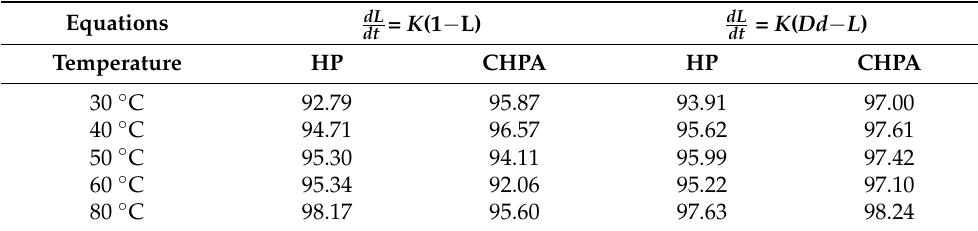
Table 6. The values of prediction coefficients (R 2 ) were acquired after estimating the parameters of two alternative pretreatment kinetics models, Equations (2) and (4).